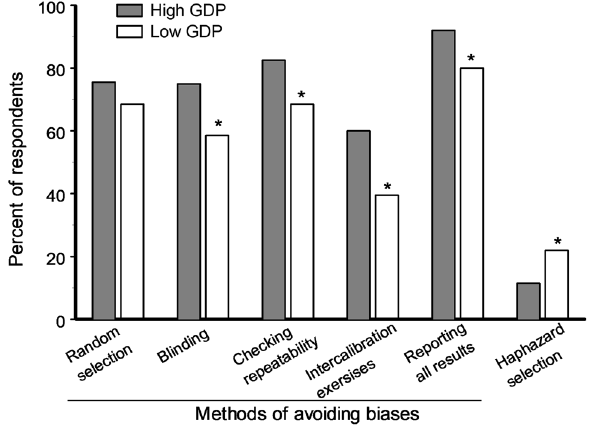
Figure 6. Percent of respondents from high and low GDP countries (219 and 82 scientists, respectively) who knew different methods for avoiding biases and who erroneously thought that haphazard selection also helps to avoid biases. Asterisks indicate significant (P < 0.05) differences between high and low GDP countries ( χ 2